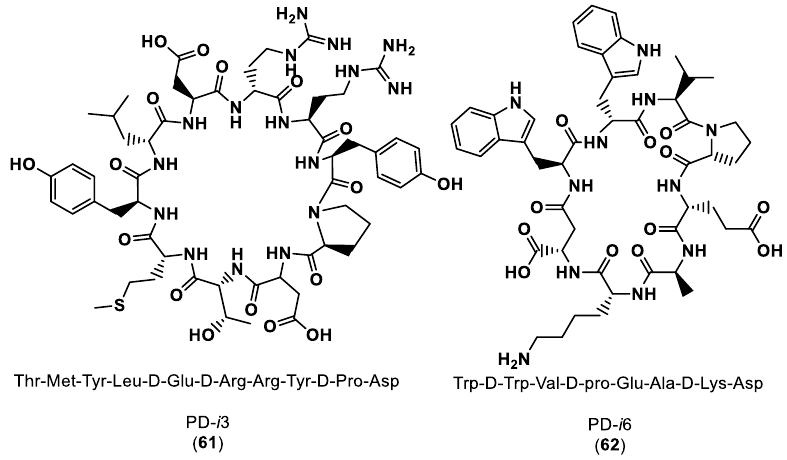
Figure 15. Structures and sequences of the designed peptide inhibitors of PD-1 [110].